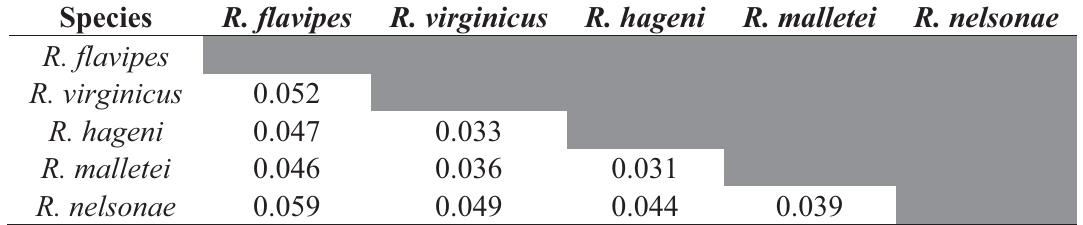
Table 5a. Estimate of net evolutionary divergence between species for COII.